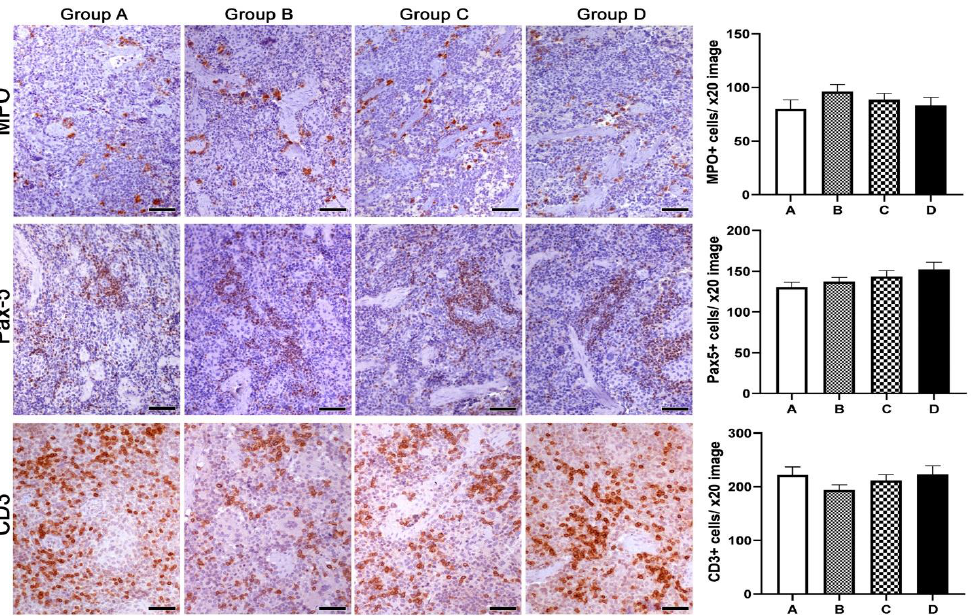
Figure 9. Effects of Spirulina treatments on inflammatory cells in the non-follicular areas of the spleen of mink progeny. Spirulina diet permutations involving progeny (group C), mothers (group B) or both (group A) did not alter the compositions of immune cell milieus compared to the non-treated control group (group D). Morphometric counts of immunohistochemically labeled inflammatory cells showed no statistically significant differences among experimental groups (bar graphs). IHC: diaminobenzidine chromogen, hematoxylin counterstain. Scale bars: 50 µ m. Numbers on the y-axes of bar graphs correspond to the means ± SEM of immune cell counts. Letters of the x- axes correspond to the experimental groups (A, B, C, D).